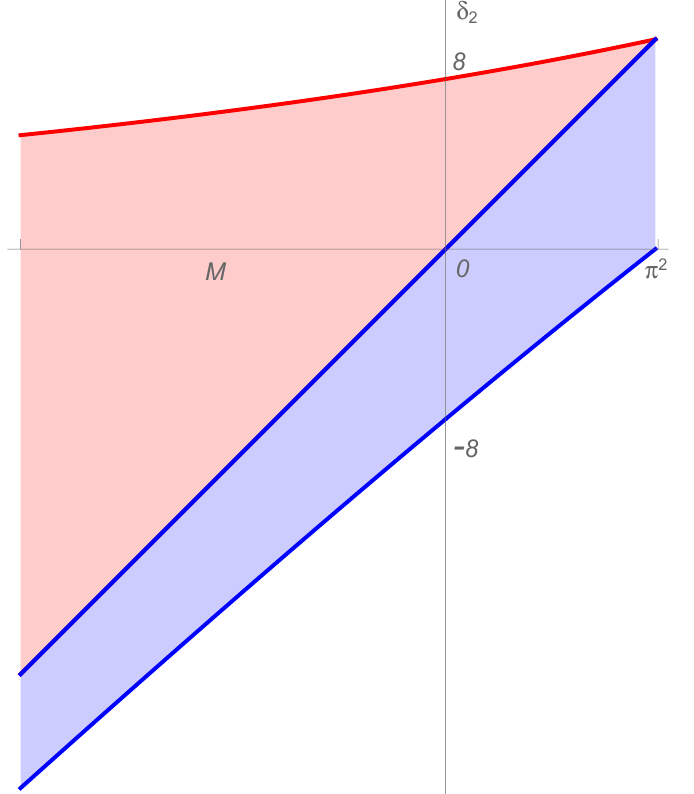
, while the red region corresponds to 2